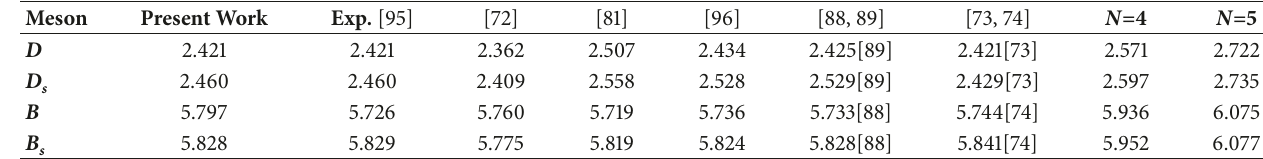
Table 5: Masses for pseudovector ( 2 S +1 𝐿 𝐽 = 1 𝑃 1 ) mesons in GeV. 𝑎 = 0.01359 GeV 3 , 𝑏 = 0.08784 GeV 2 , and 𝑐 = 0.008.